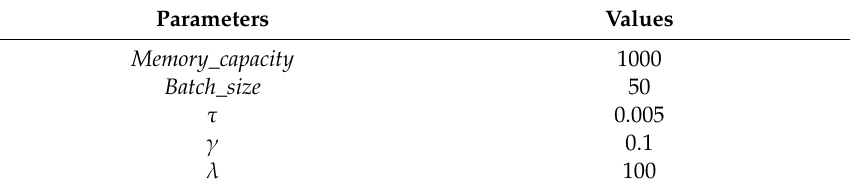
Table 4. The set of parameters in experiment